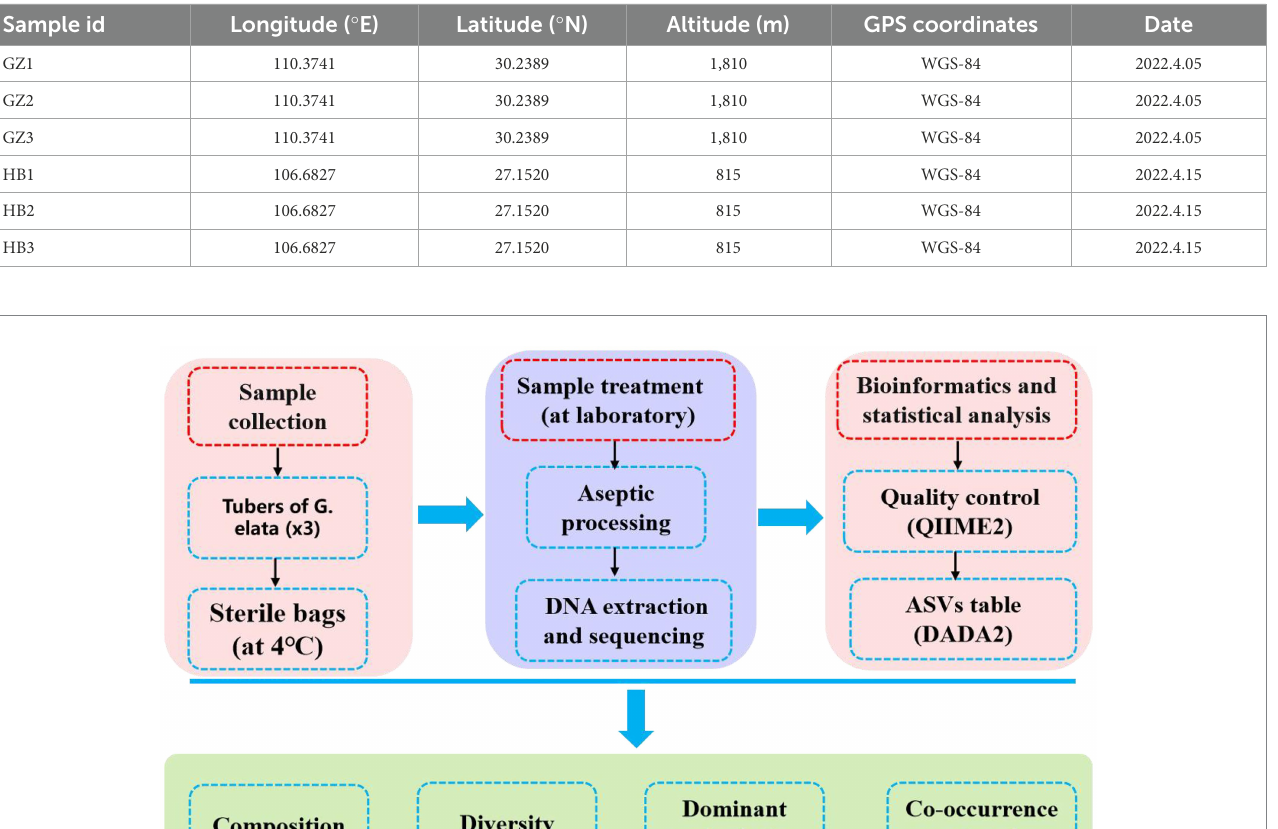
TABLE 1 Sample location